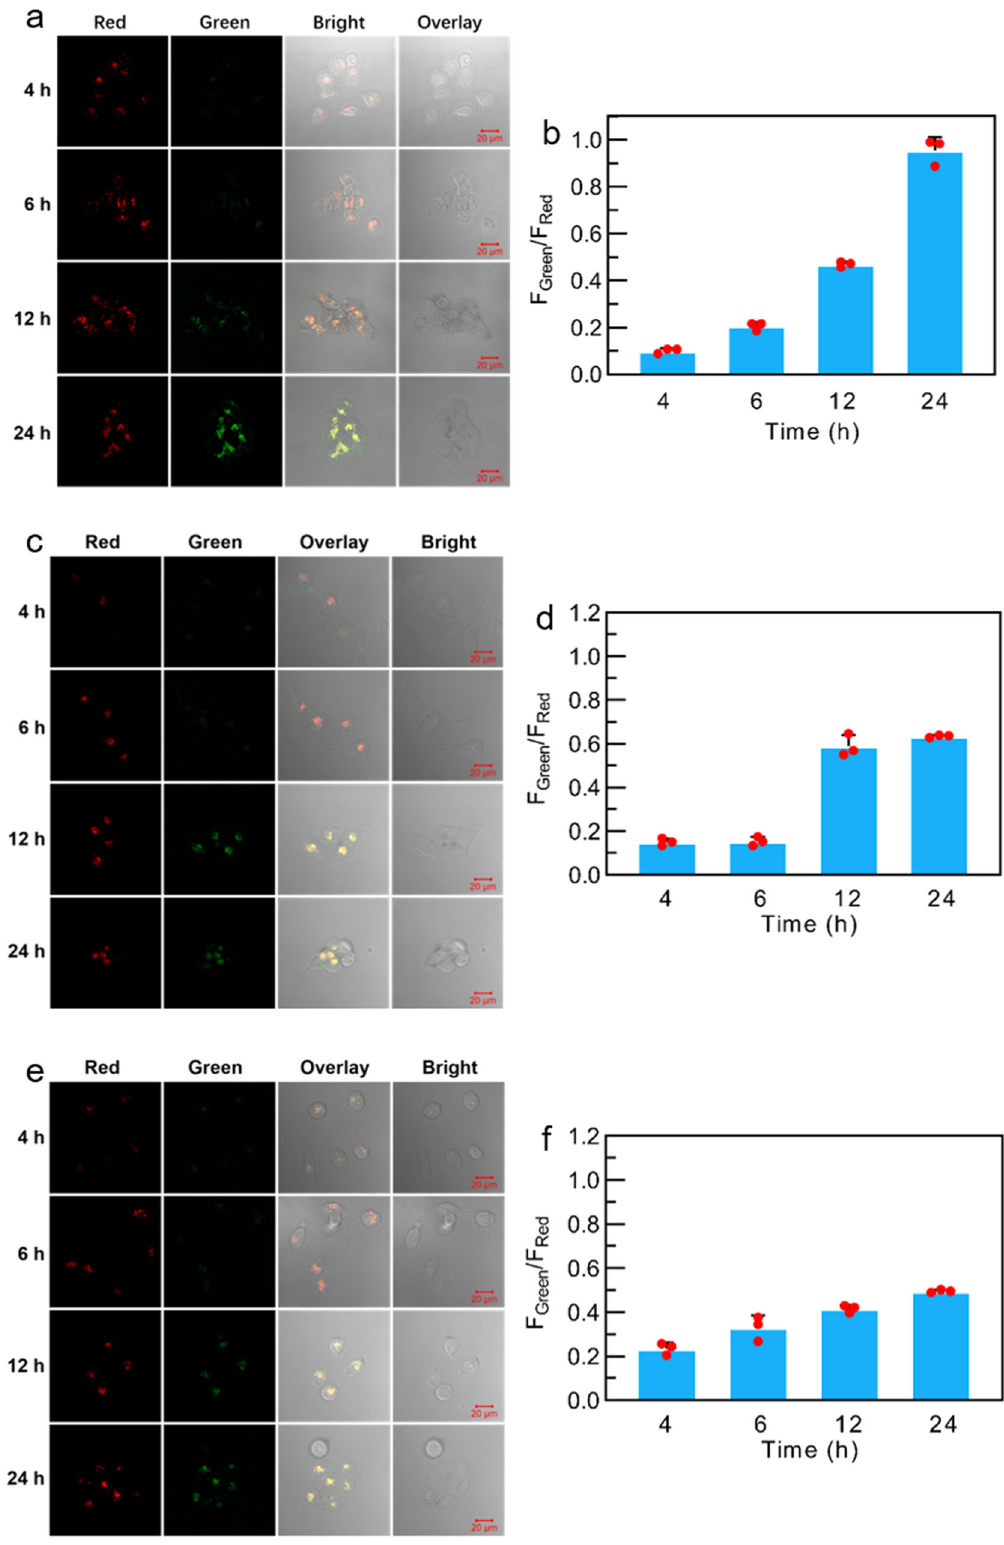
Fig. 5 Time-dependent ratiometric fl uorescence bioimaging. CLSM imaging and F green / F red data of a , b HeLa, c , d MCF-7, and e , f LO2 cells incubated with PPAB-PyS NPs (100 μ M) for 4, 6, 12, and 24 h.